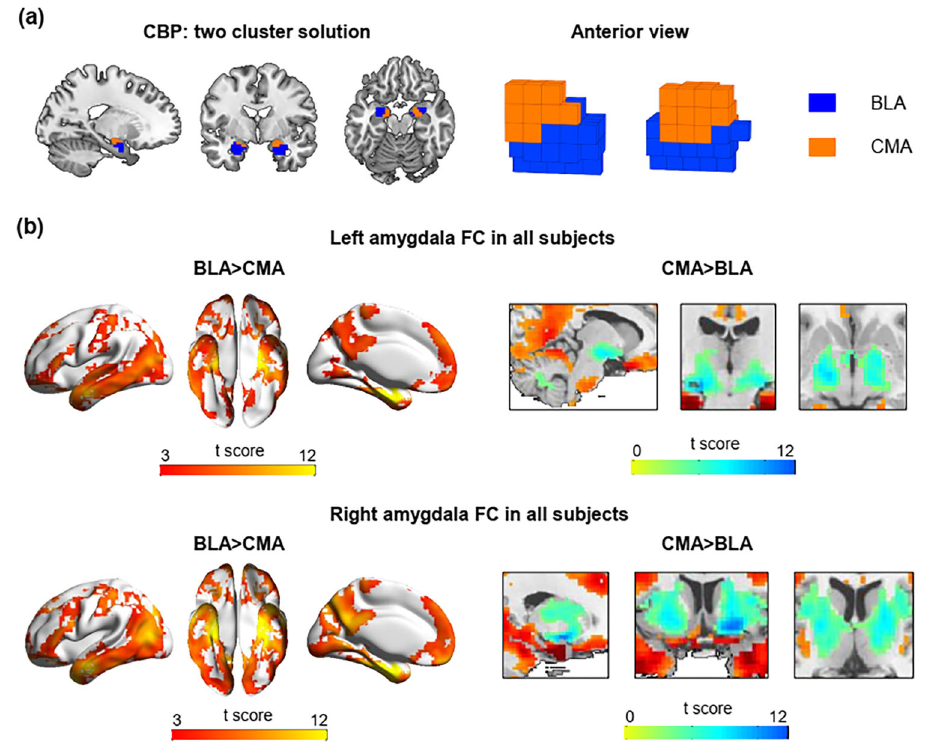
Fig. 1 Connectivity-based parcellation of the amygdala. a The two-cluster solution derived by connectivity-based parcellation (CBP). b The basolateral cluster (BLA) connectivity was primarily cortical, whereas the centromedial cluster (CMA) connectivity was primarily subcortical. Warm color (red) indicates that BLA connectivity is stronger compared to CMA connectivity whereas cool color (blue) indicates CMA connectivity is stronger compared to BLA